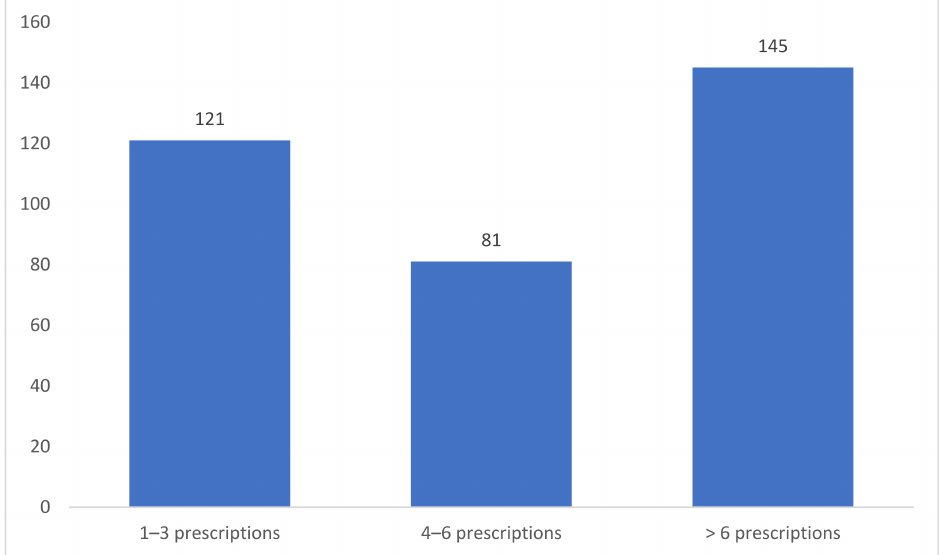
Figure 1. Number of oral contraceptives prescribed or sold